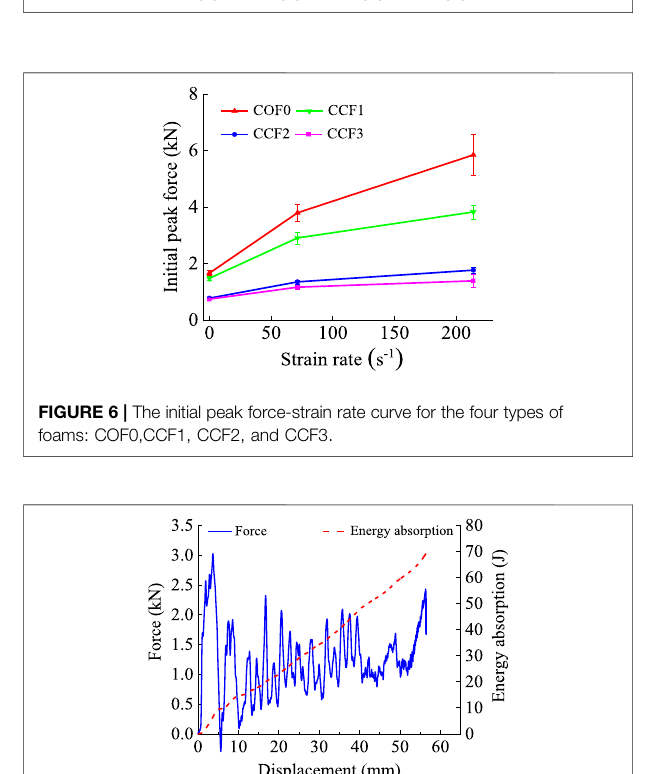
FIGURE 5 | Force-displacement curves for foam specimens under different strain rates: (A) COF0, (B) CCF1, (C) CCF2, (D) CCF3.